Question: What visual encoding does this figure use to show its data?
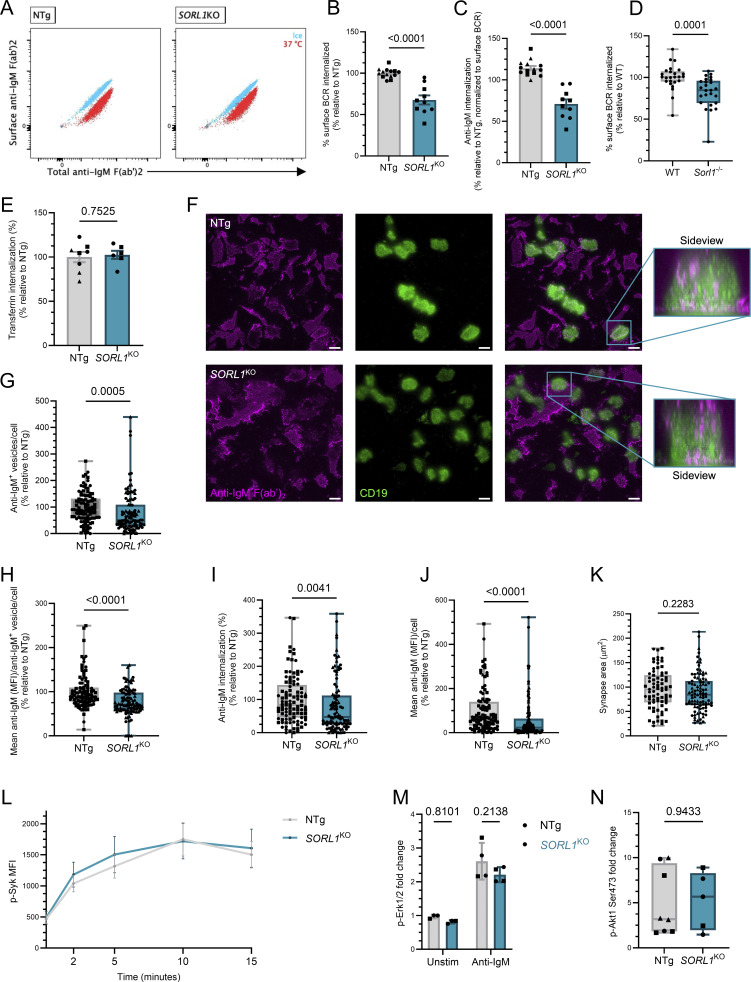
Answer: bar